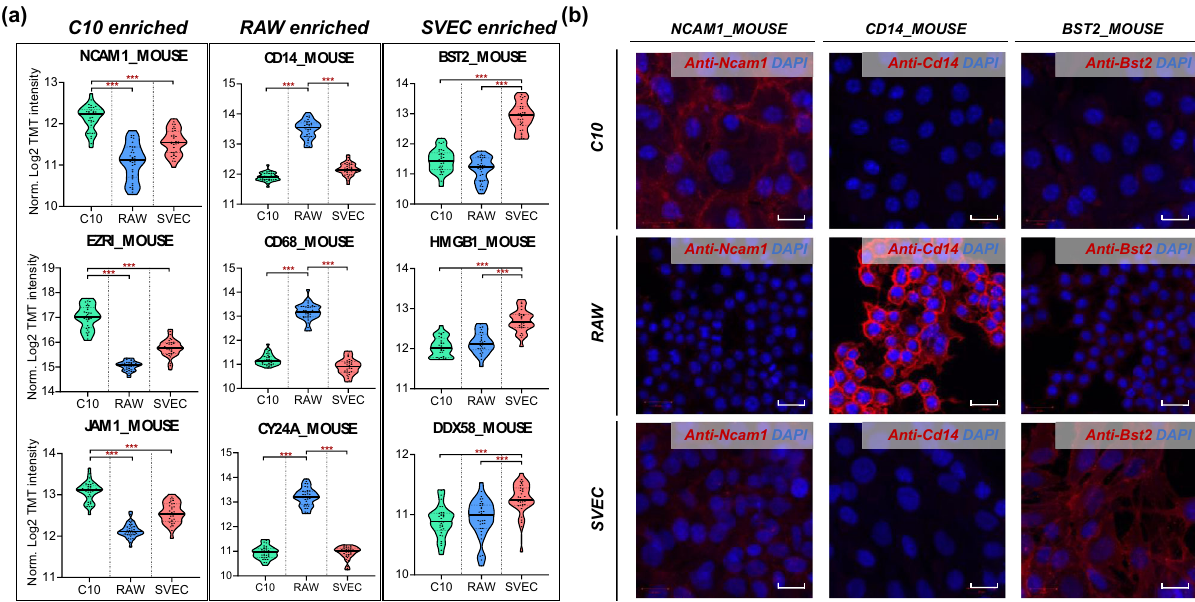
Fig. 5 Prediction of cell-type-speci fi c surface proteins with single-cell proteomics. a Violin plots showing nine putative plasma membrane proteins enriched in three cell types. Proteins in each column are statistically signi fi cant (Two-sided t -test, *** p -value ***<0.001) expressed in the speci fi c cell type. Centerlines show the medians; top and bottom horizontal lines indicate the 25th and 75th percentiles, respectively. For C10, n = 34 single cells; For RAW, n = 35 single cells; For SVEC, n = 35 SVEC single cells. b Immuno fl uorescence images showing the expression of NCAM1_MOUSE, CD14_MOUSE, and BST2_MOUSE in three cell populations. The protein abundance is visualized with red fl uorescence, and DNA is visualized by DAPI staining (blue). The length of scale bar is 20 µ m. Source data are